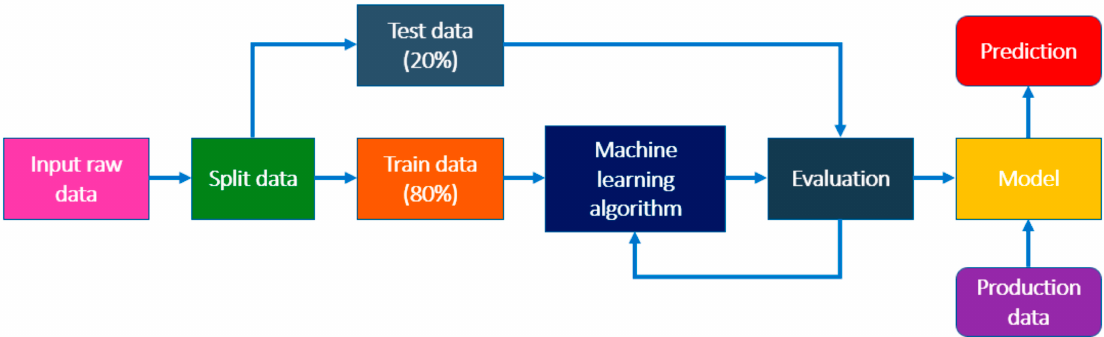
Figure 3. A supervised ML model.